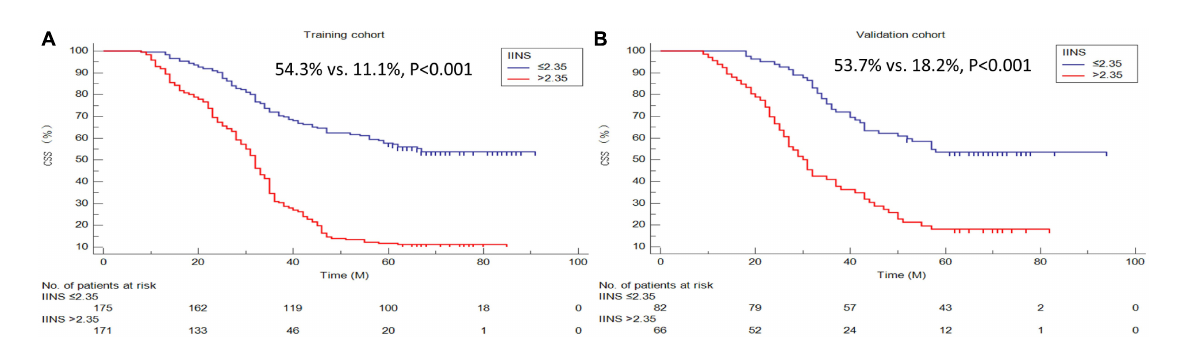
FIGURE6 Cancer-specific survival (CSS) analyses grouped by integrative inflammatory and nutritional score (IINS). Kaplan–Meier curves regarding 5-years CSS in the training cohort (A) and validation cohort (B) .